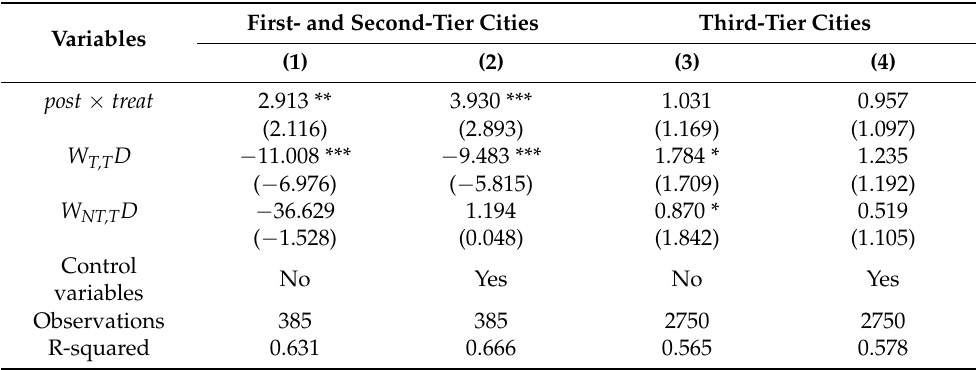
Table 7. Administrative heterogeneity results based on the SDID